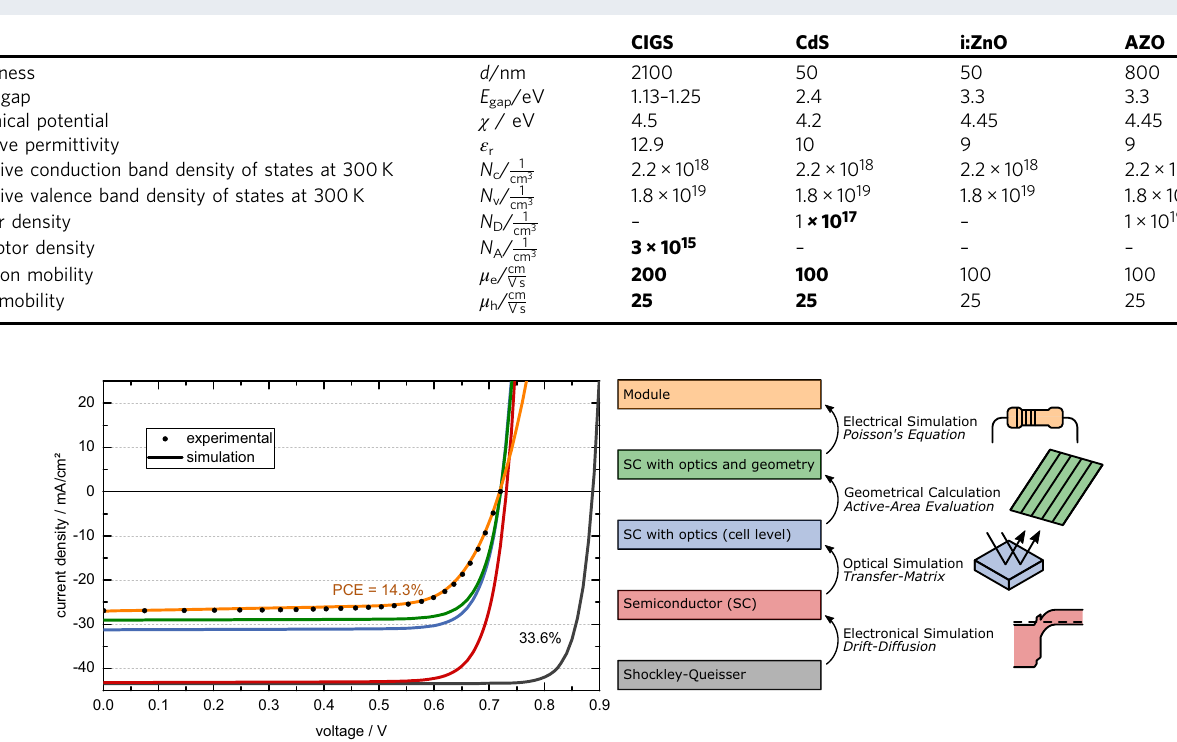
Table 1 Semiconductor parameters for drift-diffusion modeling. The material abbreviations CIGS, CdS, i:ZnO, and AZO stand for copper indium gallium diselenide, cadmium sul fi de, intrinsic zinc oxide, and aluminum-doped zinc oxide, respectively. All bold numbers are fi tted via reverse engineering fi tting procedure from the measured module I-V characteristic, all others are adapted from literature. The CIGS absorber material has a linear grading within the ratio of gallium to gallium and indium concentrations [Ga]/([Ga] + [In]) (GGI) of 0.2 to 0.4. Detailed conversions into an absorber band gap can be found in Supplementary Note 1 and band gap or in literature 69,70